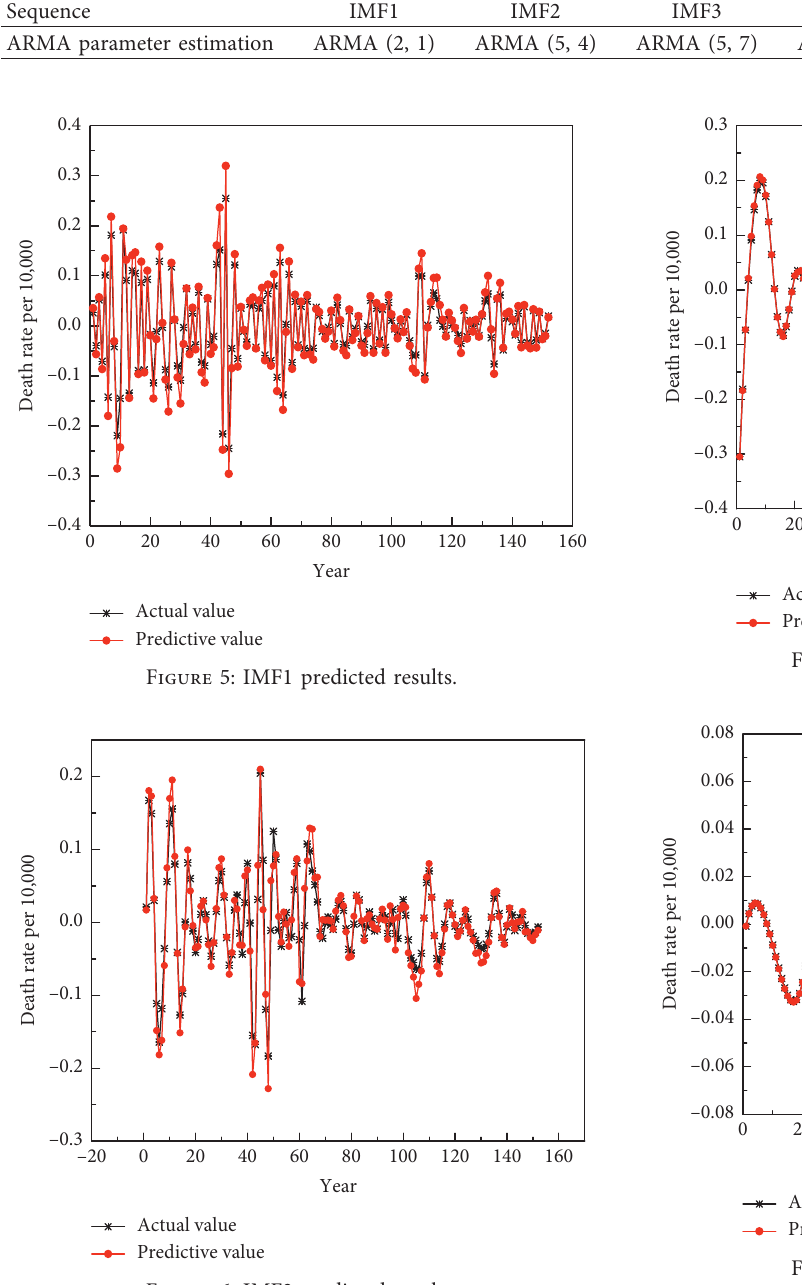
Figure 6: IMF2 predicted results.